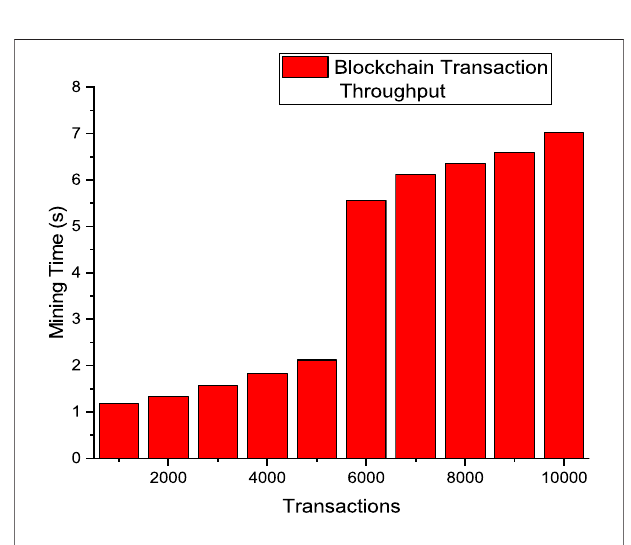
FIGURE 7 | Blockchain transaction throughput.